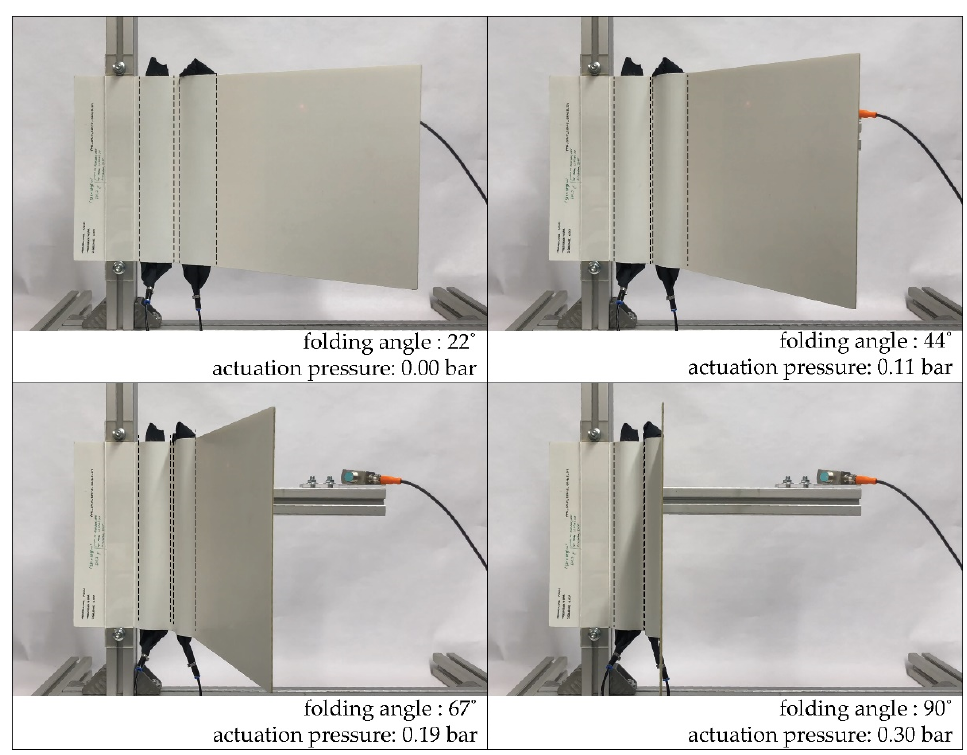
Figure 15. Mechanical testing of the hinge component with two hinges (hinge width 6.5 cm, distance between the hinges 1 cm).